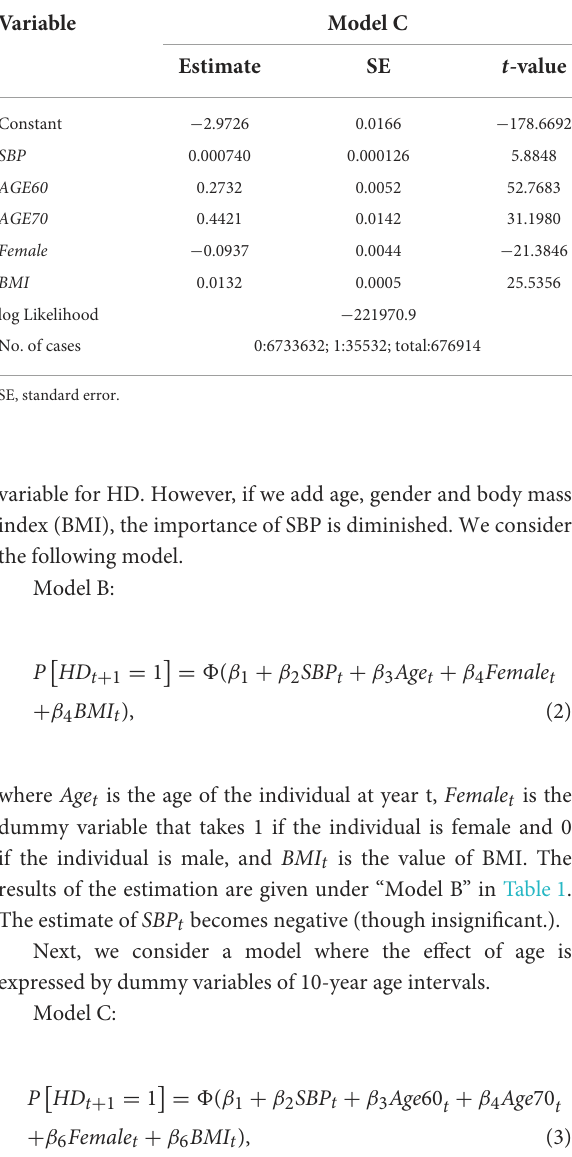
TABLE 2 Results of estimation: model